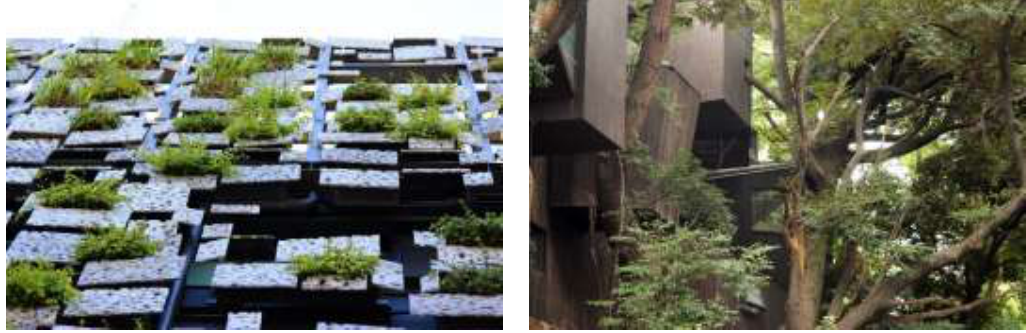
Figure 2. Green Cast , in Odawara (Kuma). Dancing Trees Singing Birds , in Tokyo (Nakamura).